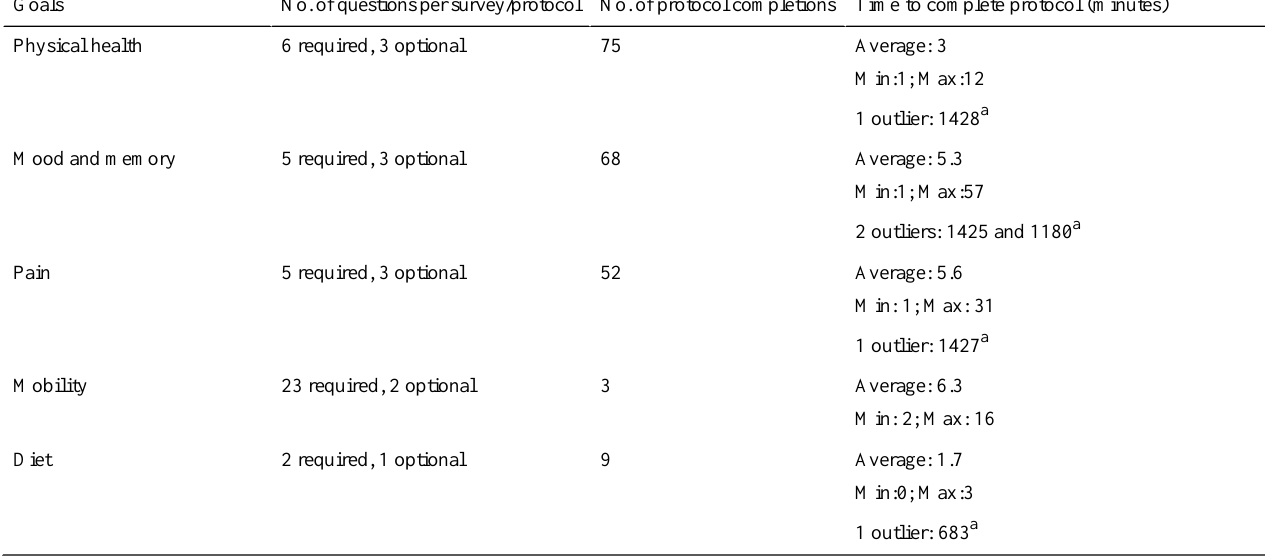
Table 3. Time to complete monitoring tasks for